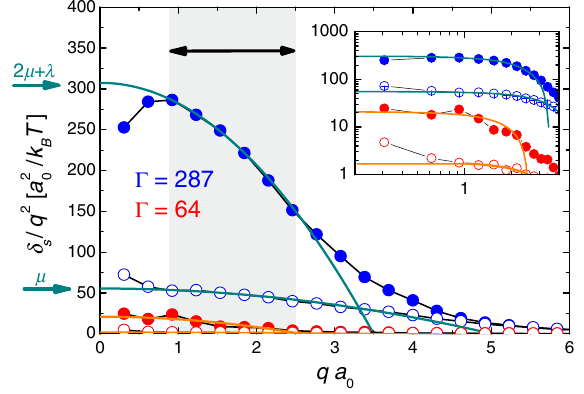
FIG. 3. μ and 2 μ þ λ are given by the intercept of an extrapolation (indicated by green arrows) derived from the longitudinal and transverse dispersion bands (filled and empty black circles) for a solid (blue) and fluid (red) sample. The gray shaded region is used for fitting the data, and the inset shows the same plot with logarithmic